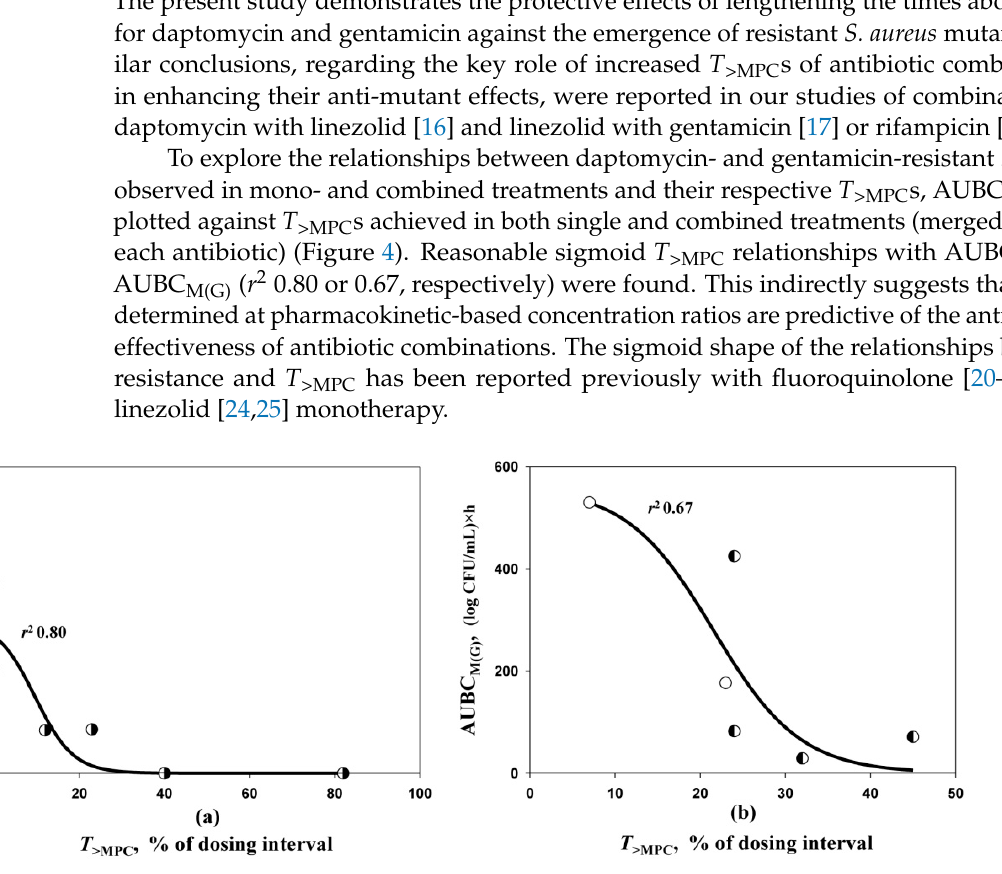
Figure 4. AUBC M(D) ( a ) and AUBC M(G) ( b )— T >MPC relationships fitted by Equation (1): Y 0 = 0, x 0 = 9.612, a = 100.4 and b = − 4.515 ( a ); Y 0 = 0, x 0 = 21.56, a = 559.3 and b = − 0.5106 ( b ). Filled symbols—daptomycin, empty symbols—gentamicin, semi-filled symbols—antibiotic combination.